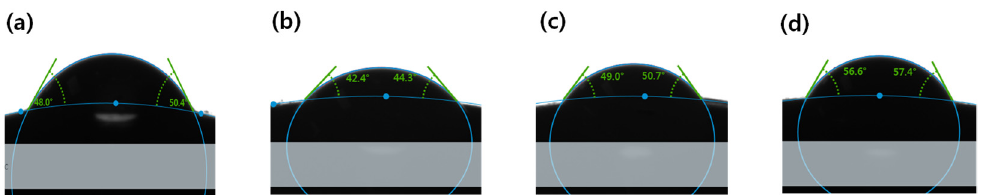
Figure 10. Change of contact angle and water content of samples. ( a ) PVP group; ( b ) NVP group.